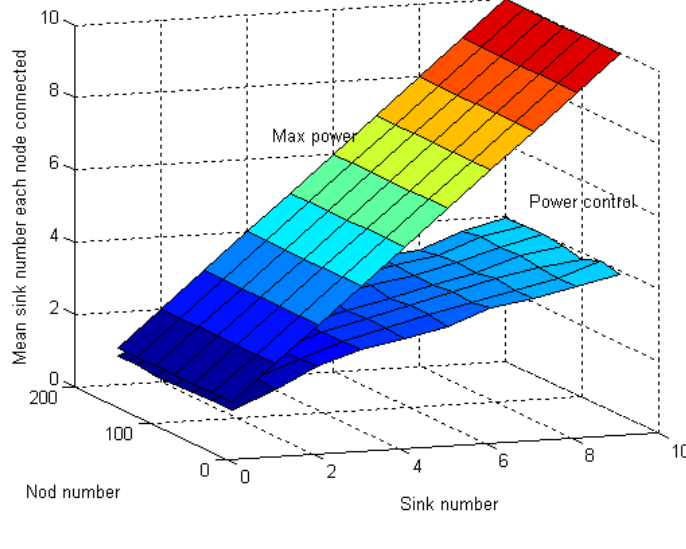
Figure 17. Mean connectivity at variety node number and sink number (100